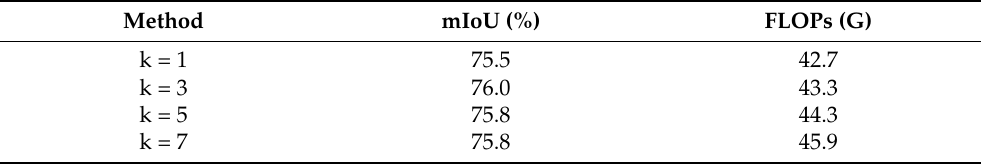
Table 3. Ablation study on kernel size k in local-level context module.